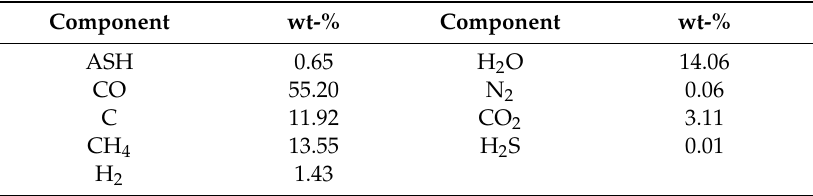
Table 2. Mass yields [wt-%] for DECOMP Aspen Plzus ® block for industrial wood pellets according to pyrolysis model of Neves et al. [48] (T = 900 ◦